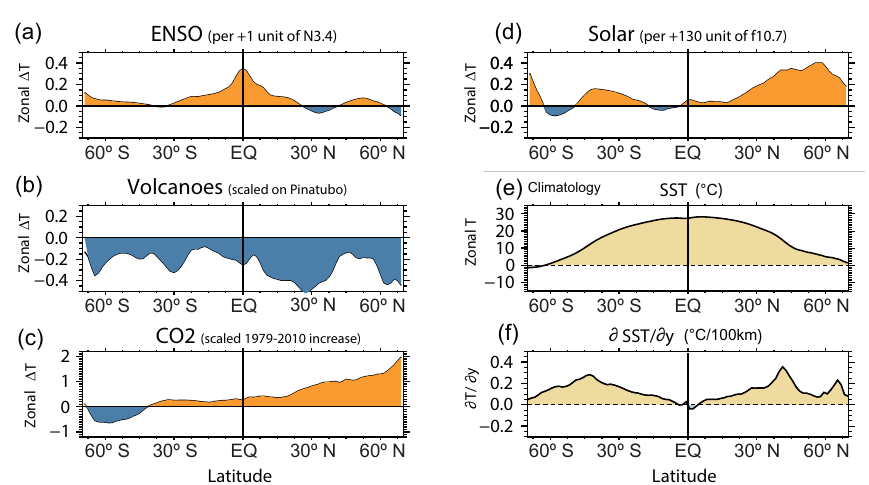
Figure 2. MLR analysis of the annual zonal mean surface temperature from ERA-I, calculated for the period 1979–2010, for (a) ENSO, (b) volcanic activity and (c) CO 2 concentration, and (d) solar activity. Climatological zonal mean SSTs and their equatorward meridional gradient are also shown in (e) and (f) , respectively.